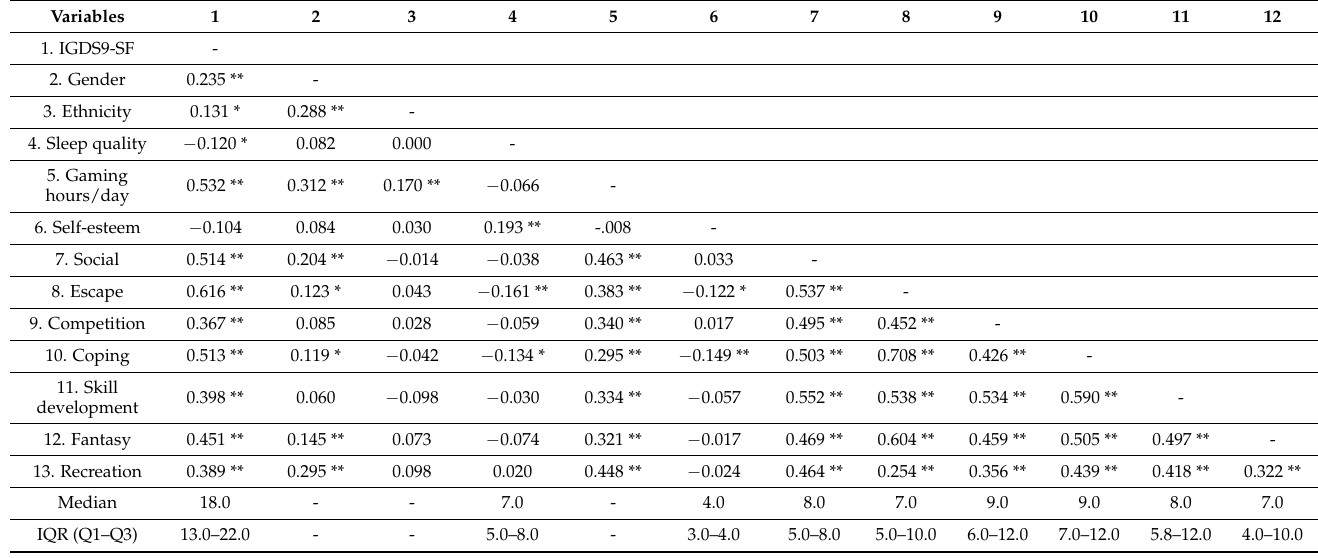
Table 3. Descriptive statistics of and correlation of the Internet Gaming Disorder Scale 9—Short form (IGDS9-SF) with criterion variables among university students from Sri